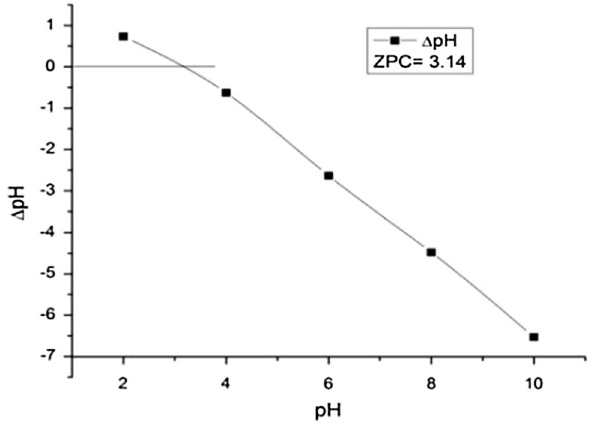
Fig. 5 Effect of initial concentration of